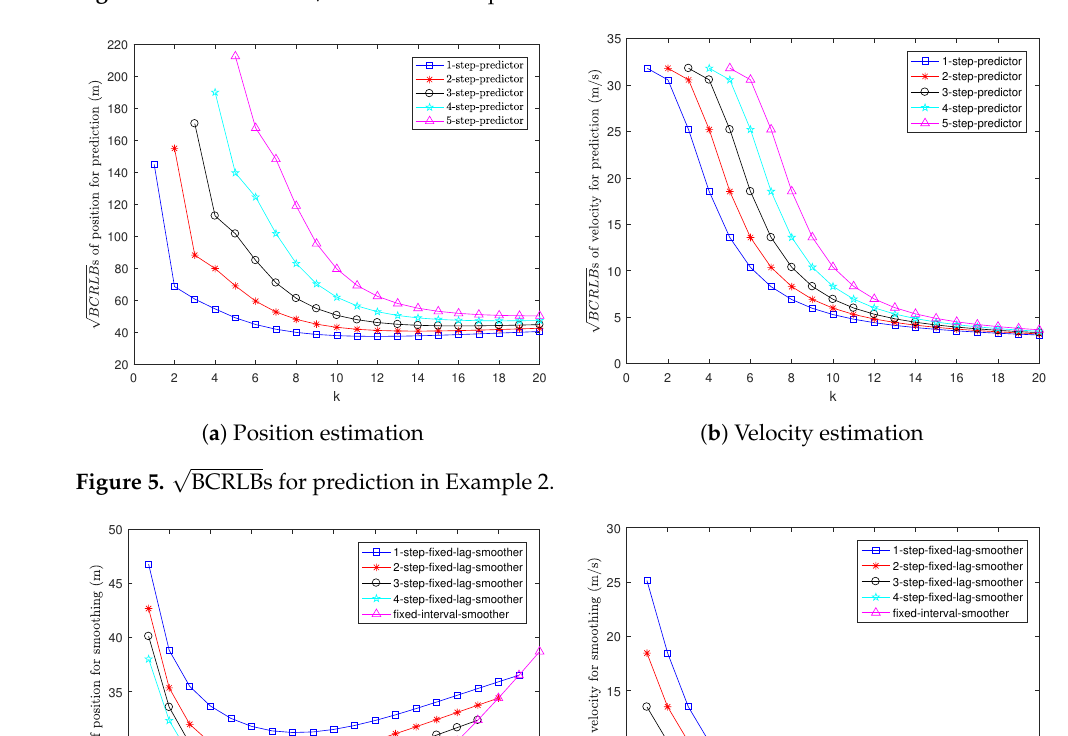
√ BCRLB in Example 2.